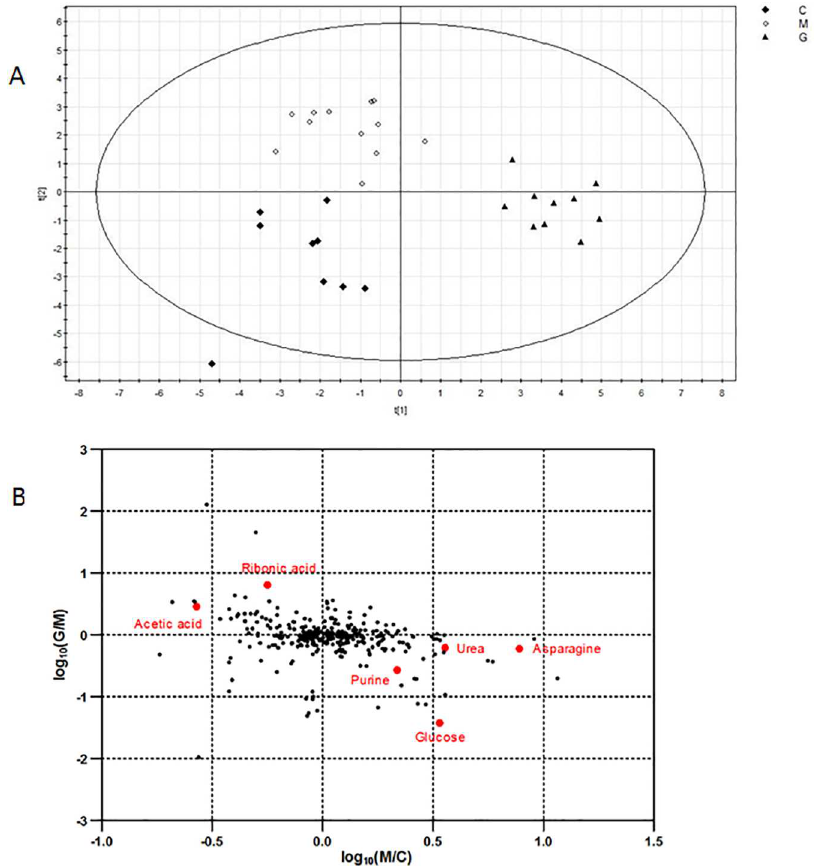
Fig 3. Metabolomics analysis of gypenoside-treated liver fibrosis rats. (A) Score plots of PCA analysis of control group, model group and gypenoside group. (B) Log-logplot of the two conditionsM/C and G/M basedon metaboliteexpressionratios. Outstanding metaboliteexpressionchangesare indicatedaccording to their names, and other unlabeledoutstanding metaboliteswere not identified. (C: control group; M: liver fibrosis model group; G: gypenoside